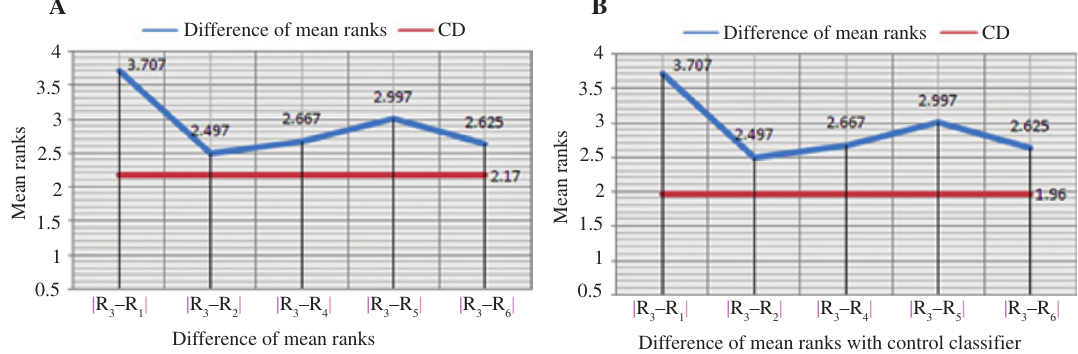
Figure 9: Graphical Representation of Comparison of Multiple Classifiers for (A) Nemenyi’s Test and (B) Bonferroni-Dunn’s Test After Applying HSA.